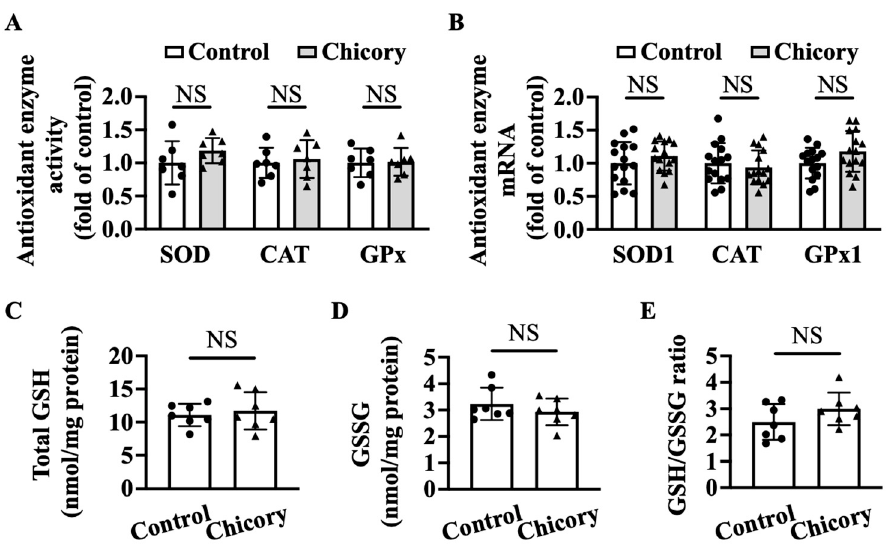
Figure 6. Brussels chicory does not alter enzymatic and non-enzymatic molecules with antioxi- dant function in the aortas of Apoe − / − mice. ( A ) Antioxidant activities of superoxide dismutase (SOD), catalase (CAT,) and glutathione peroxidase (GPx) in thoracic and abdominal aortas ( n = 7). ( B ) Relative SOD1, CAT, and GPx1 expression in the aortic arches at the mRNA level assessed by qRT-PCR ( n = 15). ( C – E ) Total glutathione (GSH) ( C ) and oxidized GSH (GSSG) ( D ) content and the ratio of reduced GSH to GSSG ( E ) in thoracic and abdominal aortas ( n = 7). Data are presented as means ± SD. Apoe, apolipoprotein E; Chicory, Brussels chicory; NS, nonsignificant ( p ≥